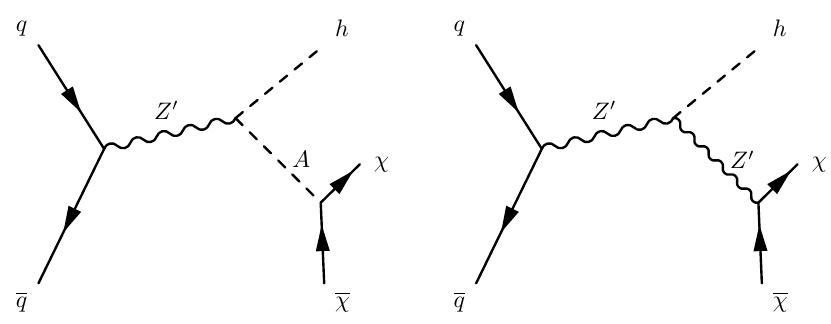
Figure 1 . Leading order Feynman diagrams for DM associated production with a Higgs boson for two theoretical models: Z -2HDM (left) and baryonic Z 0 0